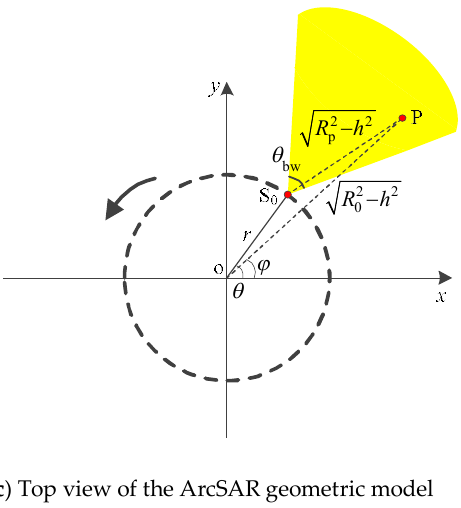
( c ) Top view of the ArcSAR geometric model Figure 1. The geometric model of ArcSAR system.